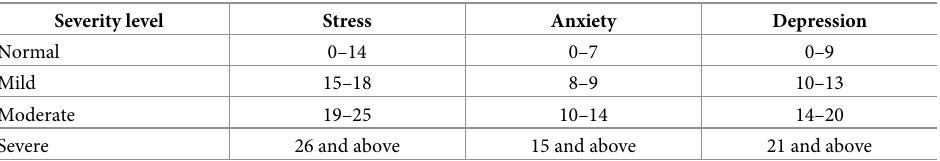
Table 1. Severity level and score